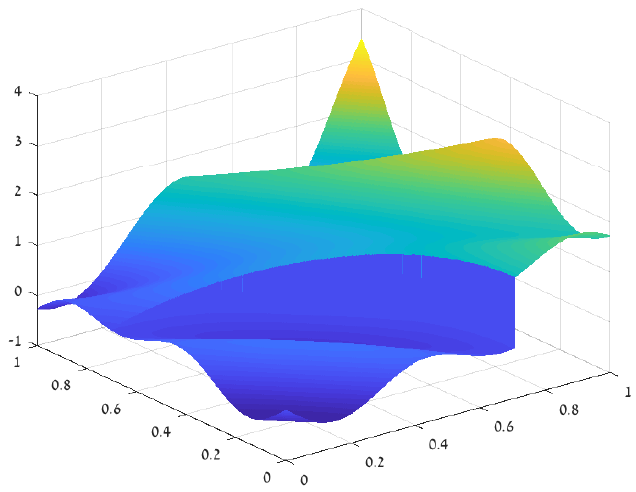
Figure 11. The test function for the 2D non-smooth case.